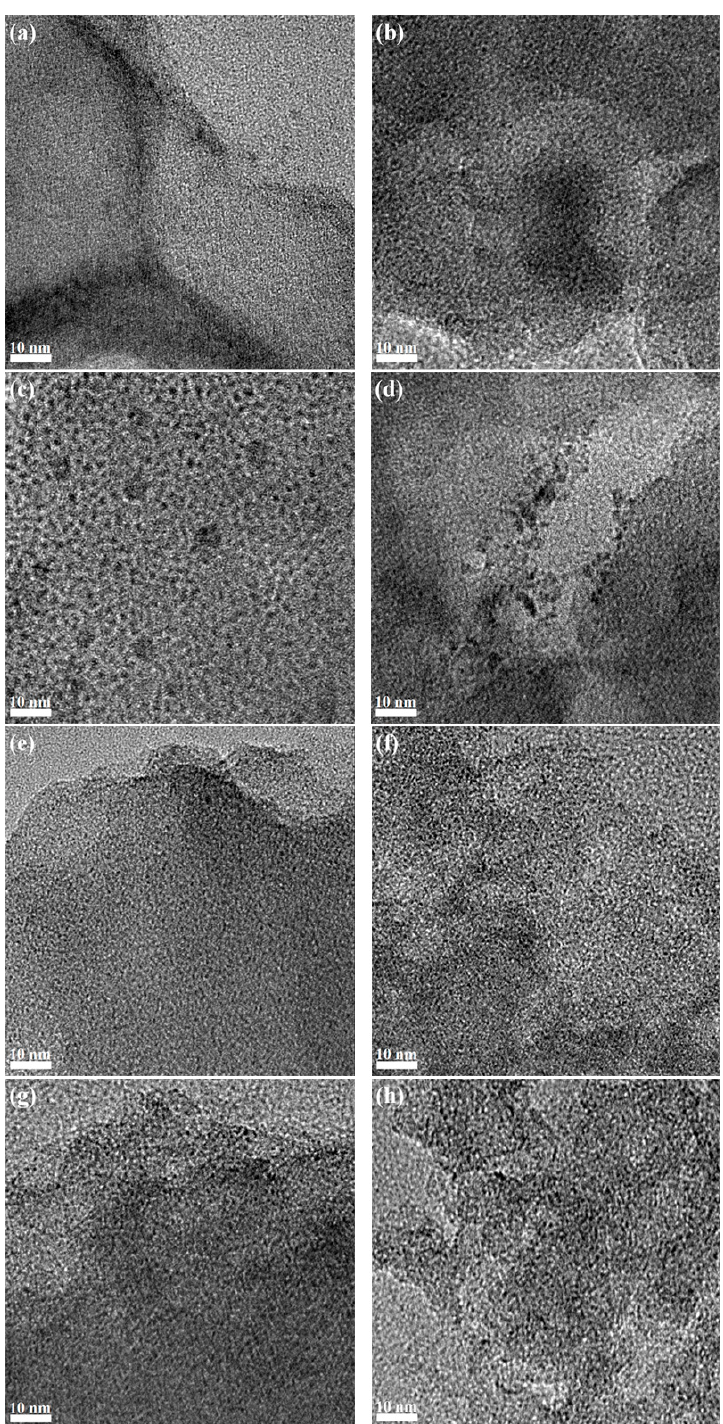
Figure 5. Transmission electron microscopy (TEM) images of the fresh and spent Ru ‐ based catalysts: ( a ) fresh Ru/AC, ( b ) spent Ru/AC, ( c ) fresh TPAP/AC, ( d ) spent TPAP/AC, ( e ) fresh TPAP/AC ‐ HCl, ( f ) spent TPAP/AC ‐ HCl, ( g ) fresh TPAP/ AC ‐ HNO, ( h ) spent TPAP/AC ‐ HNO 3 .